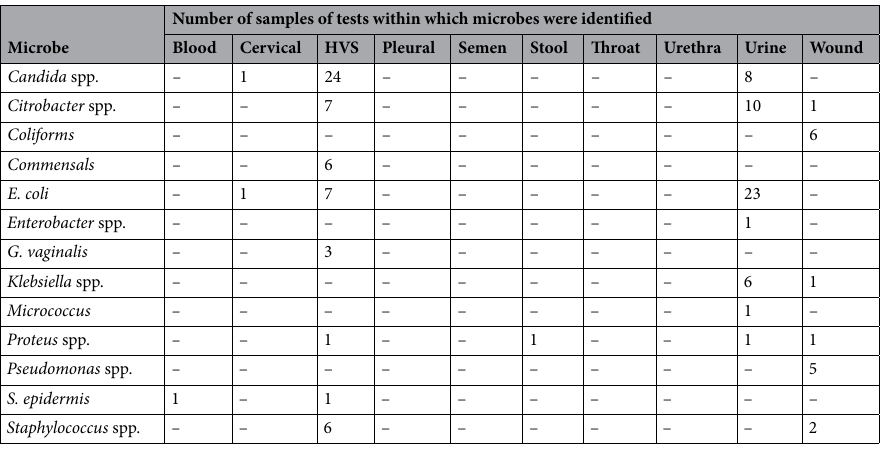
Table 2. Prevalence of Microorganisms in samples.